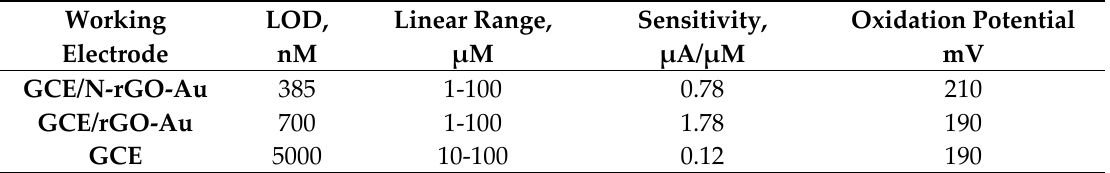
Figure 1. CVs of the examined electrodes in 0.1 M PBS containing 100 µM of DA. Table 1. Working parameters of DA